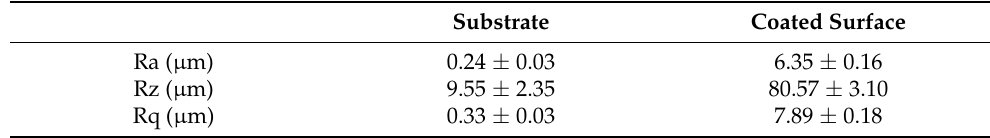
Table 2. Average roughness (R a ), peak-to-valley roughness (R z ) and root-mean-square roughness (R q ) determined by 3D